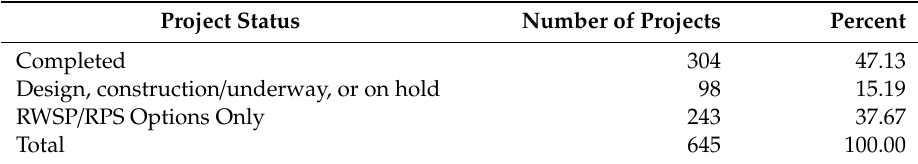
Table 4. Project number, size, and total capacity, by project types.